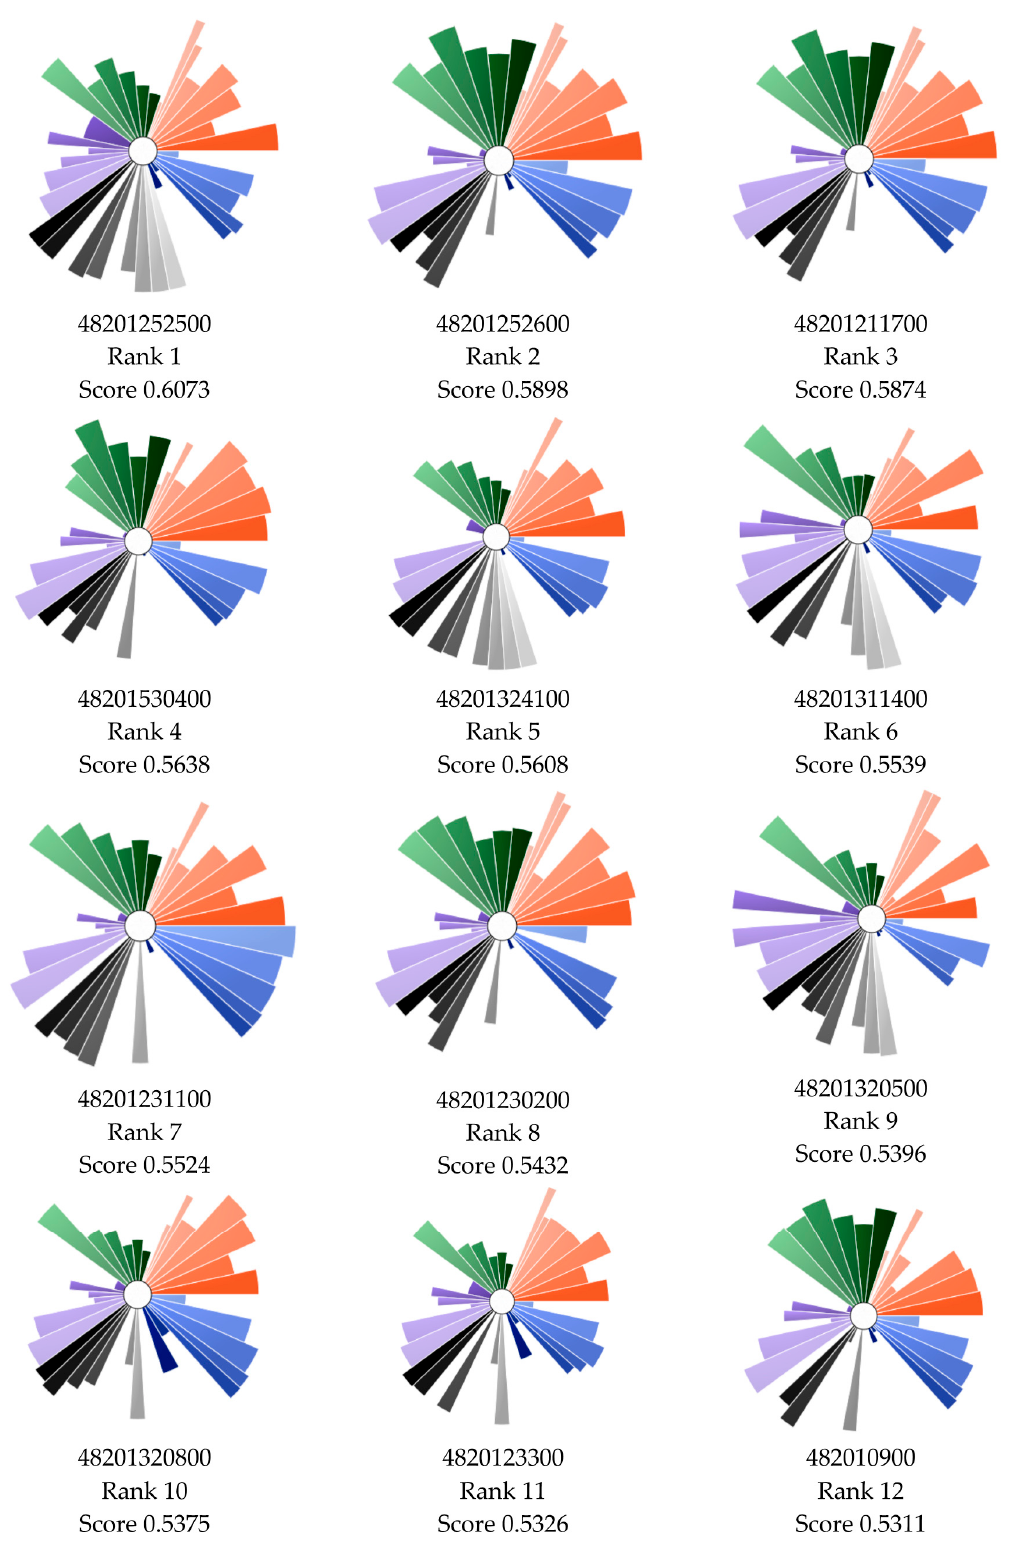
Figure 3. ToxPi visualizations of the top 10 ranking census tracts. ToxPi indicator colors are shown in Figure 1 (starting from the 3 o’clock position, going counterclockwise: orange = social vulnerability; green = baseline health; purple = environmental exposures and risks; grey = environmental sources; blue = flooding).